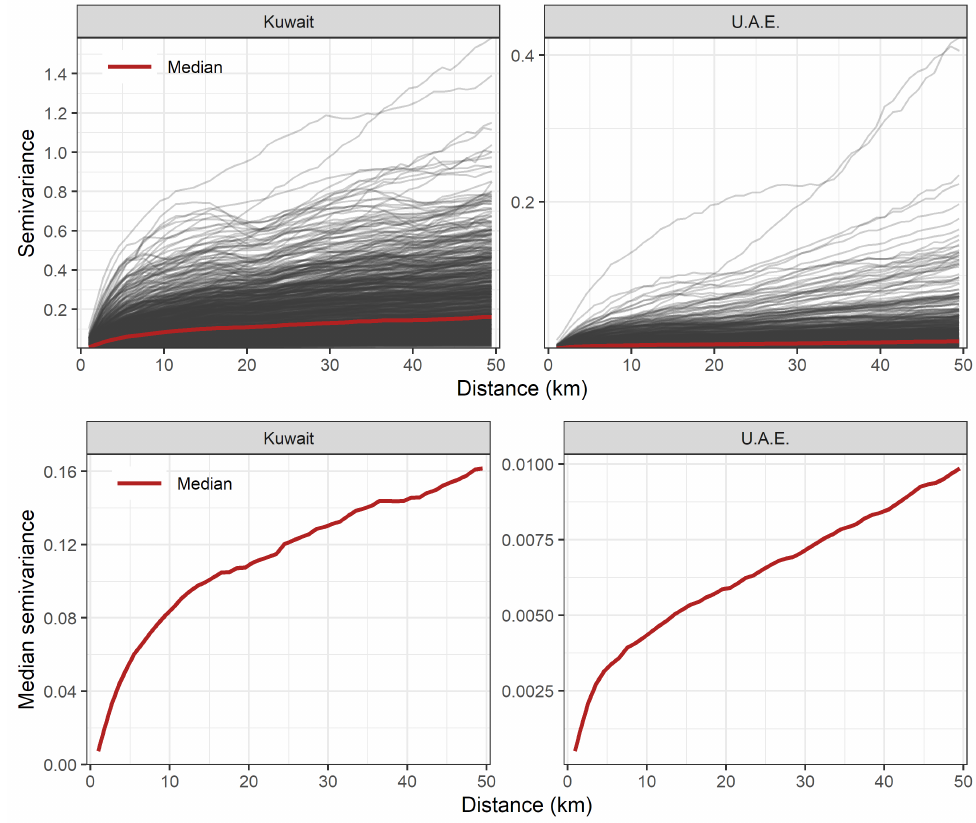
Figure 8. Daily semivariograms for MAIAC AOD in Kuwait and the U.A.E. (grey lines in top row) and median semivariograms (red lines in both top and bottom